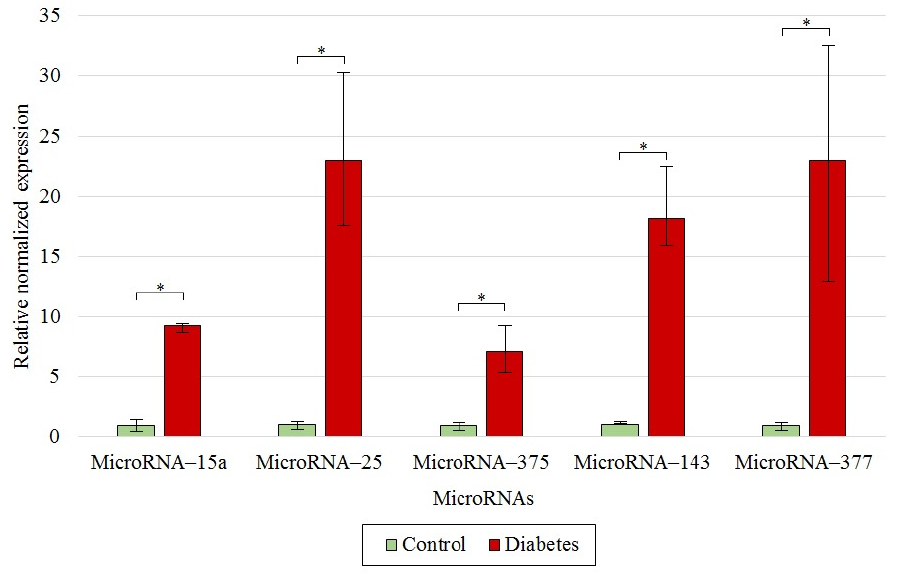
Figure 6. Expression analysis of microRNAs in type 1 diabetes (* p ≤